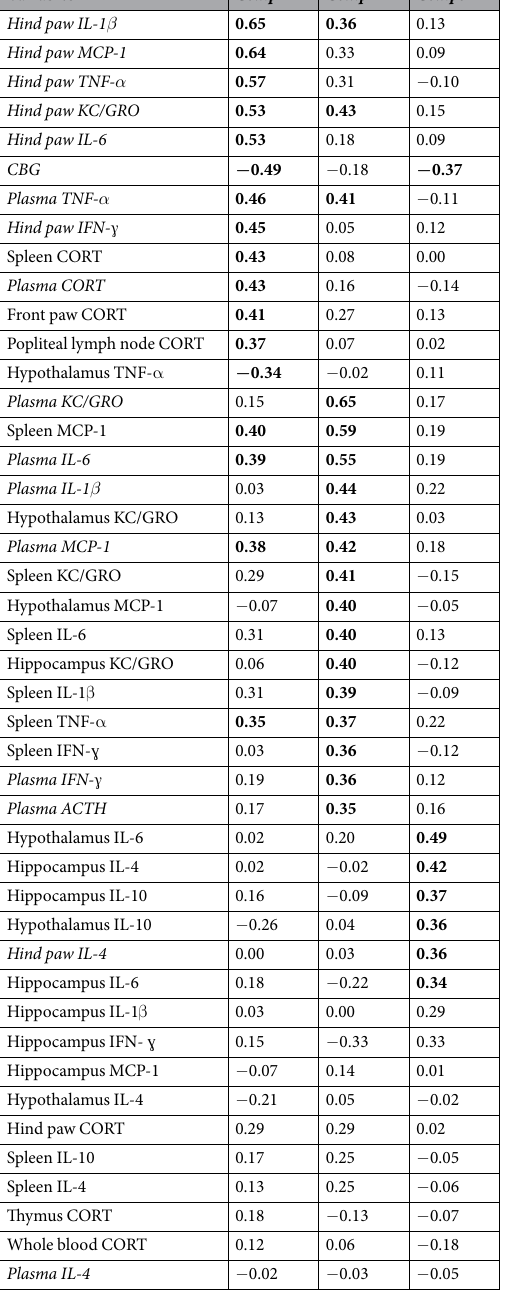
Table 1. Component loadings for the endocrine/immune variance constrained to that predictable from colony and AA severity. Networks are interpreted using loadings set in bold font. Note. Values ≥ 0.34 are set in bold. Previously reported measures 21 are indicated in